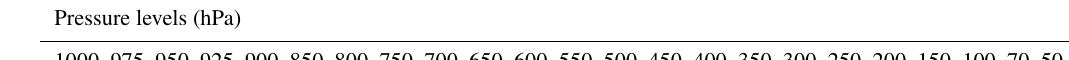
Table A3. Pressure levels to which three-dimensional atmospheric variables are interpolated. Pressure levels (hPa)